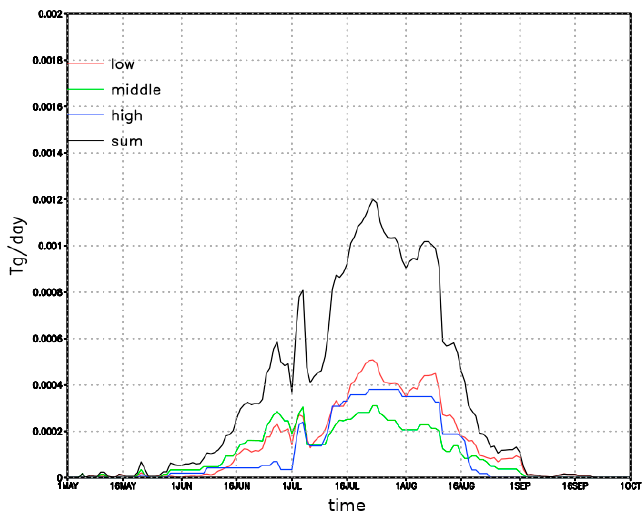
Figure 2. Annual course of BC emission from forest fires in Siberia in 2019. Black line—total emission rate (Tg/day), red—first class of fires, green—second class of fires, blue—third class of fires. Emission sources corresponding to the different classes were set at model levels, the height of which approximately corresponded to the above values (100 m, 500 m, 1500 m).